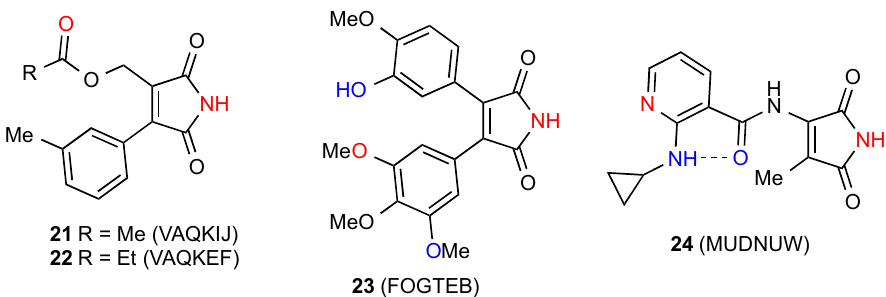
Figure 6. Disubstituted maleimides forming ribbon pattern B. Three structures, 21 , 22 [26] and 23 [27] (Figure 7) show a linear chain where the NH of the